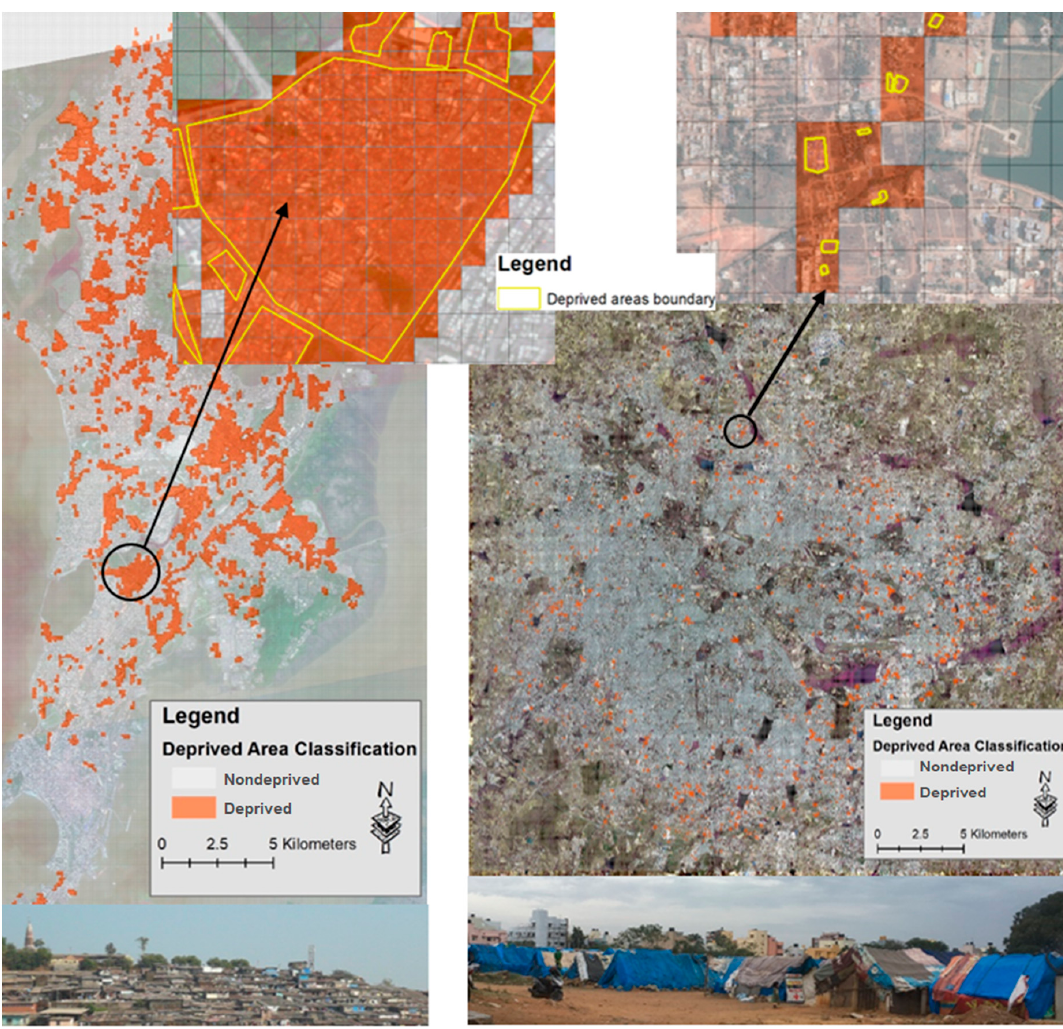
Figure 8. Mumbai deprived areas mapped at an aggregation level of 100 m (left) on top of a Planetscope image; Bangalore with the same 100-m grid (right) on top of Pleiades images and ground photo of a temporary settlement in Bangalore (lower right).